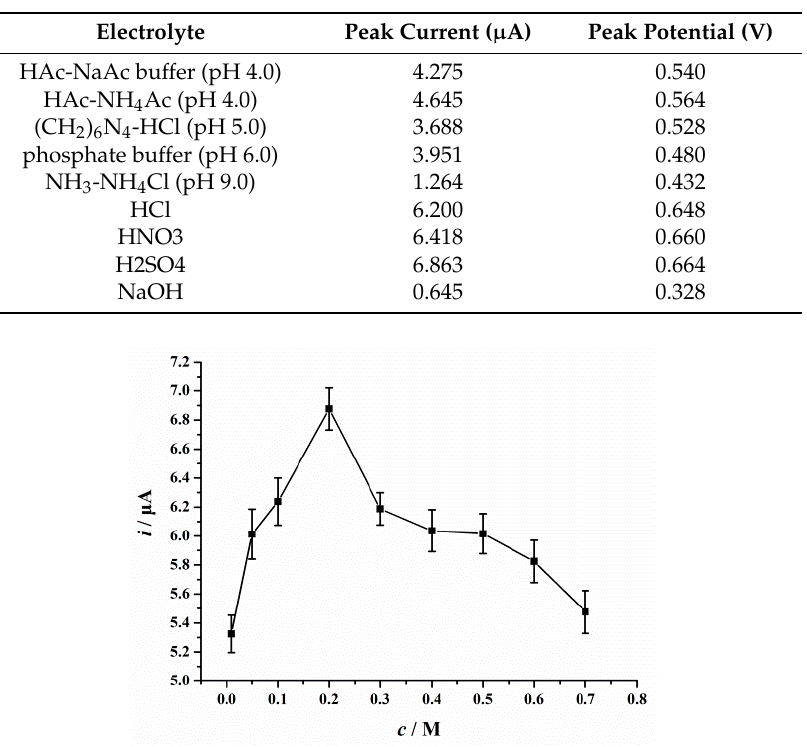
Table 2. Effect of different supporting electrolytes (0.1 M) on the current and potential response of